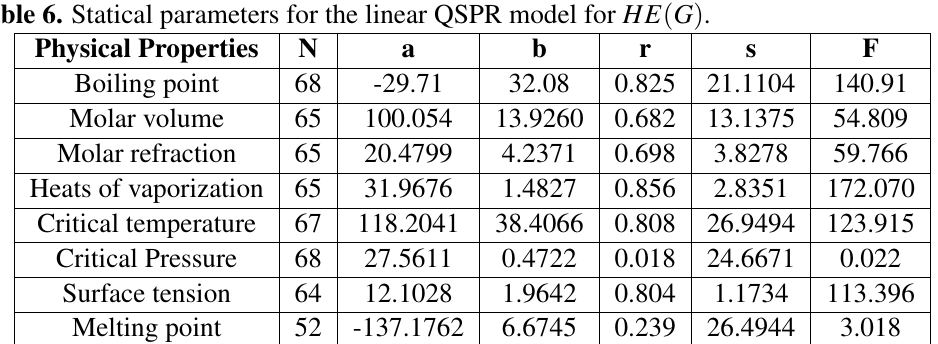
Table 6. Statical parameters for the linear QSPR model for HE ( G )